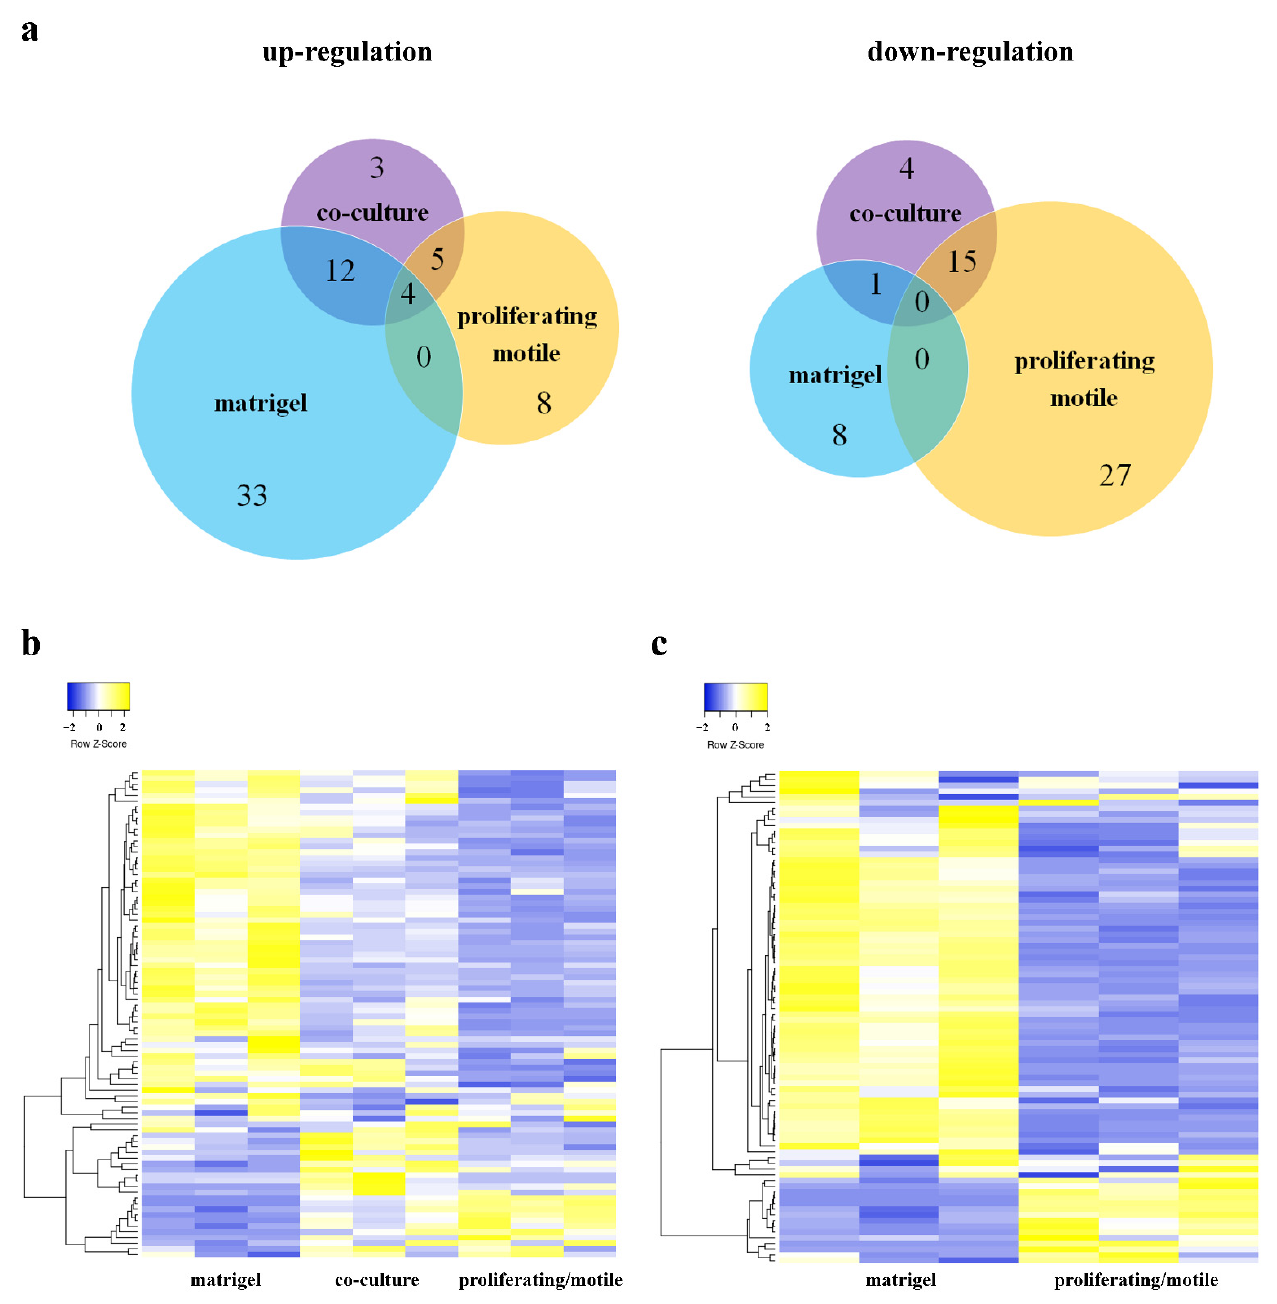
Figure 2. ( a ) Venn diagram summarizes the number of significantly changed genes ( p < 0.05) that are differentially upregulated or downregulated between experimental groups compared to the HUVEC static monolayer. ECs from direct co-culture were separated using anti CD31 magnetic beads. Total RNA was isolated and specific mRNA levels were quantified by qRT PCR as described in “Methods”. ( b ) Hierarchical clustering dendrograms of differentially expressed mRNA expression patterns in HUVECs on Matrigel TM , in co-culture with MSCs, and proliferating/motile HUVECs analyzed using online software Heatmapper [8]. The data are presented in three repeats. Clustering Method: Average linkage. Distance Measurement Method: Pearson. ( c ) Hierarchical clustering dendrograms of differentially expressed mRNA expression patterns in HUVECs on Matrigel TM and proliferating/motile HUVECs analyzed using the online software Heatmapper [8]. The data are presented in three repeats. Clustering Method: Average linkage. Distance Measurement Method: Pearson.